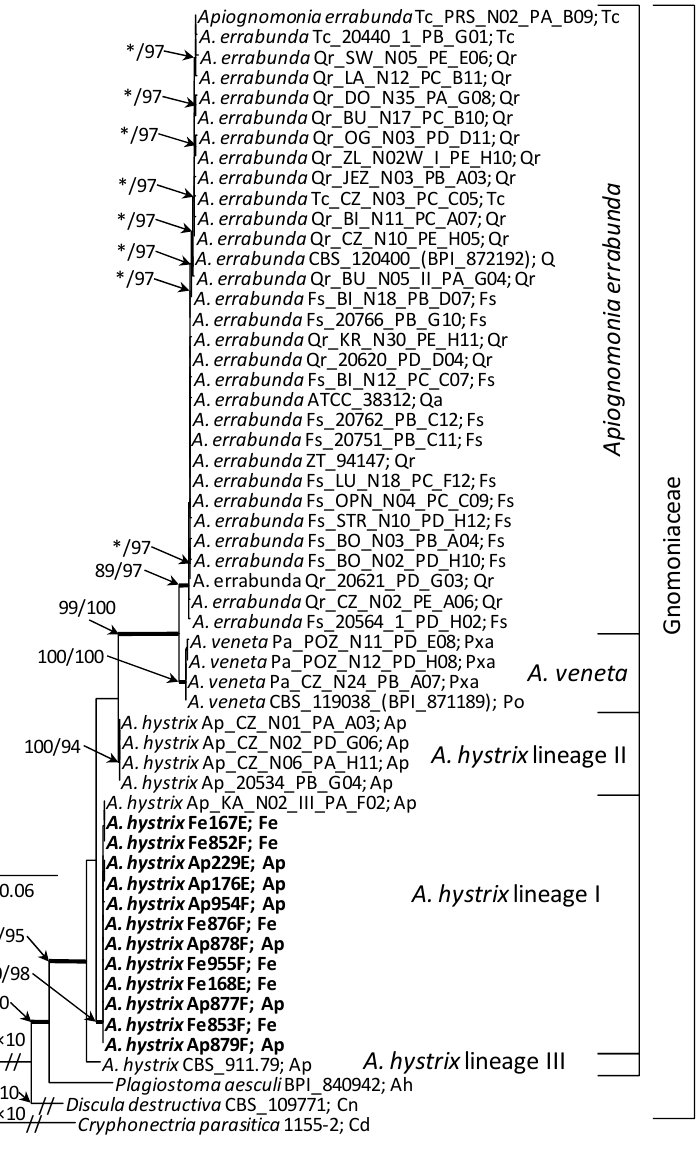
Figure 6. Phylogram obtained in maximum likelihood (ML) analysis of the combined ITS-ACT-CAL datasets of the Apiognomonia spp. and selected species from Gnomoniaceae. Sequences obtained in this study are marked in bold type. The bootstrap values ≥ 75% for ML and maximum par- simony (MP) analyses are presented at the nodes using ML/MP pattern. Bold branches indicate posterior probability values ≥ 0.95 obtained in Bayesian Inference (BI) analysis. * Bootstrap val- ues < 75%. The tree is drawn to scale (see bar) with branch length measured in the number of substitutions per site. Cryphonectria parasitica 1155-2 represents the outgroup. The